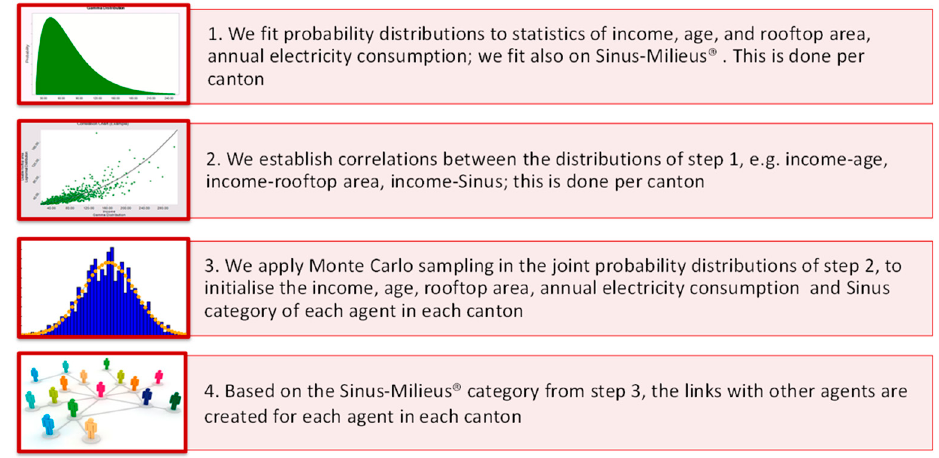
Figure A3. Overview of the process of creating a synthetic population of Figure A 3. Overview of the process of creating a synthetic population of agents.